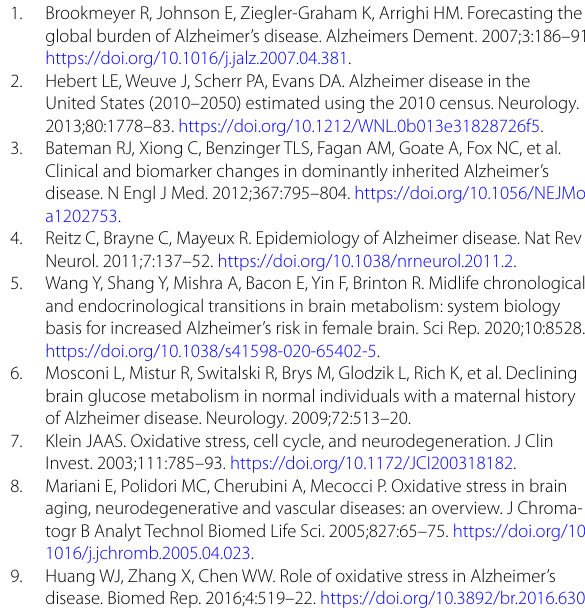
Table S1 . Summary of regional SUVR 40–60 statistical analysis in age‑ and gender‑matched APP/PS1 and WT mice at the age of 5, 10, and 16 mo. Table S2 . Information of